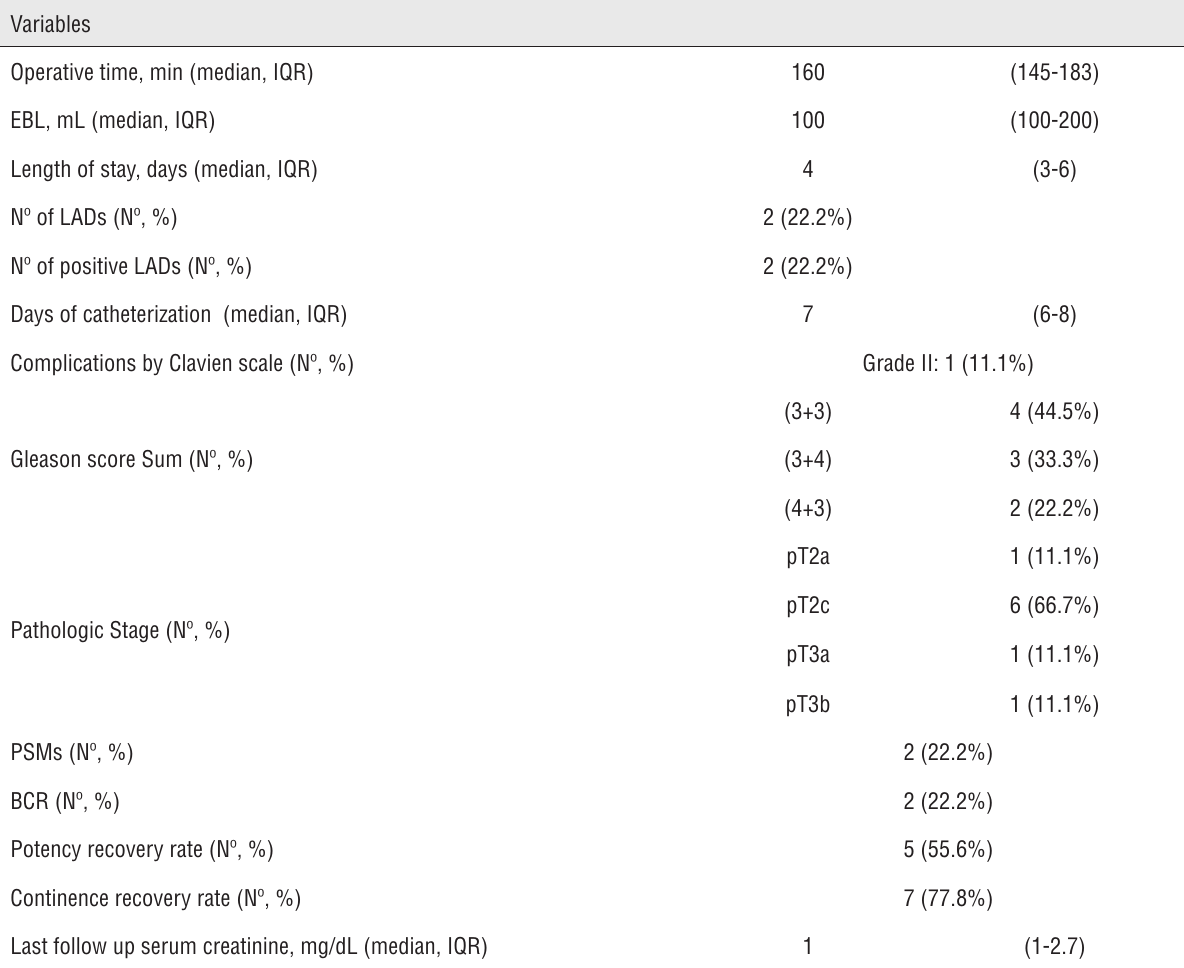
Table 2-Robotic and assistant port positioning for RS-RARP.